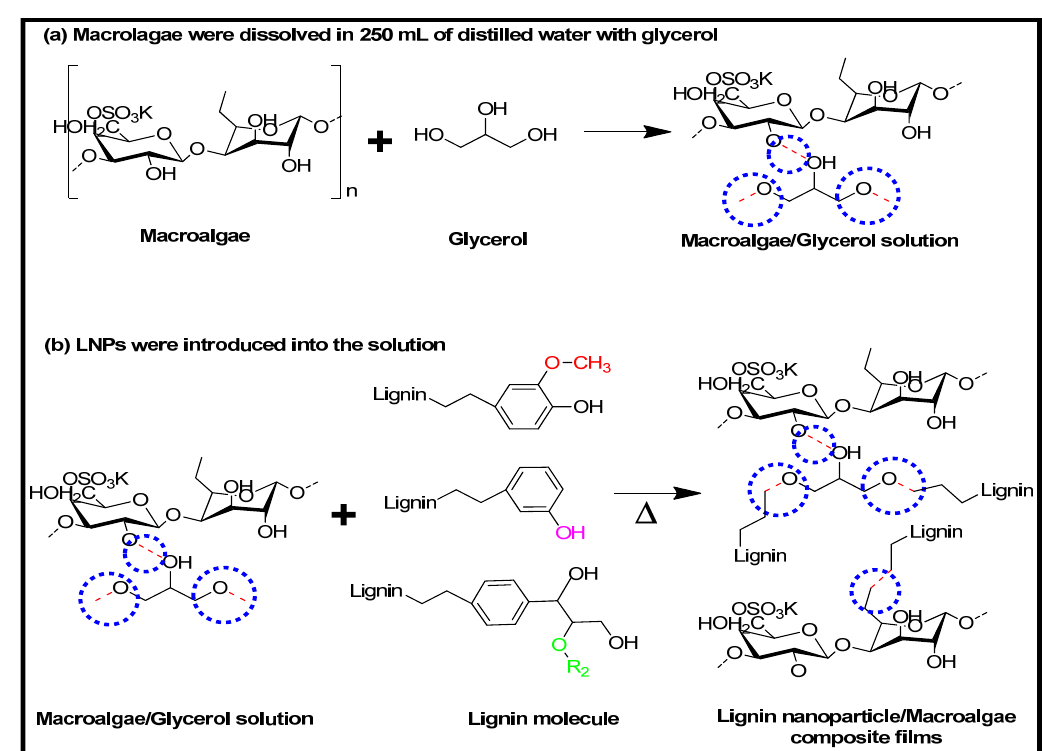
Figure 6. Proposed chemical reaction mechanism of macroalgae biocomposite film functioned with LNPs. The blue circle represents the hydrogen bond. The red circle represents a free available oxygen atom to form a hydrogen bond.